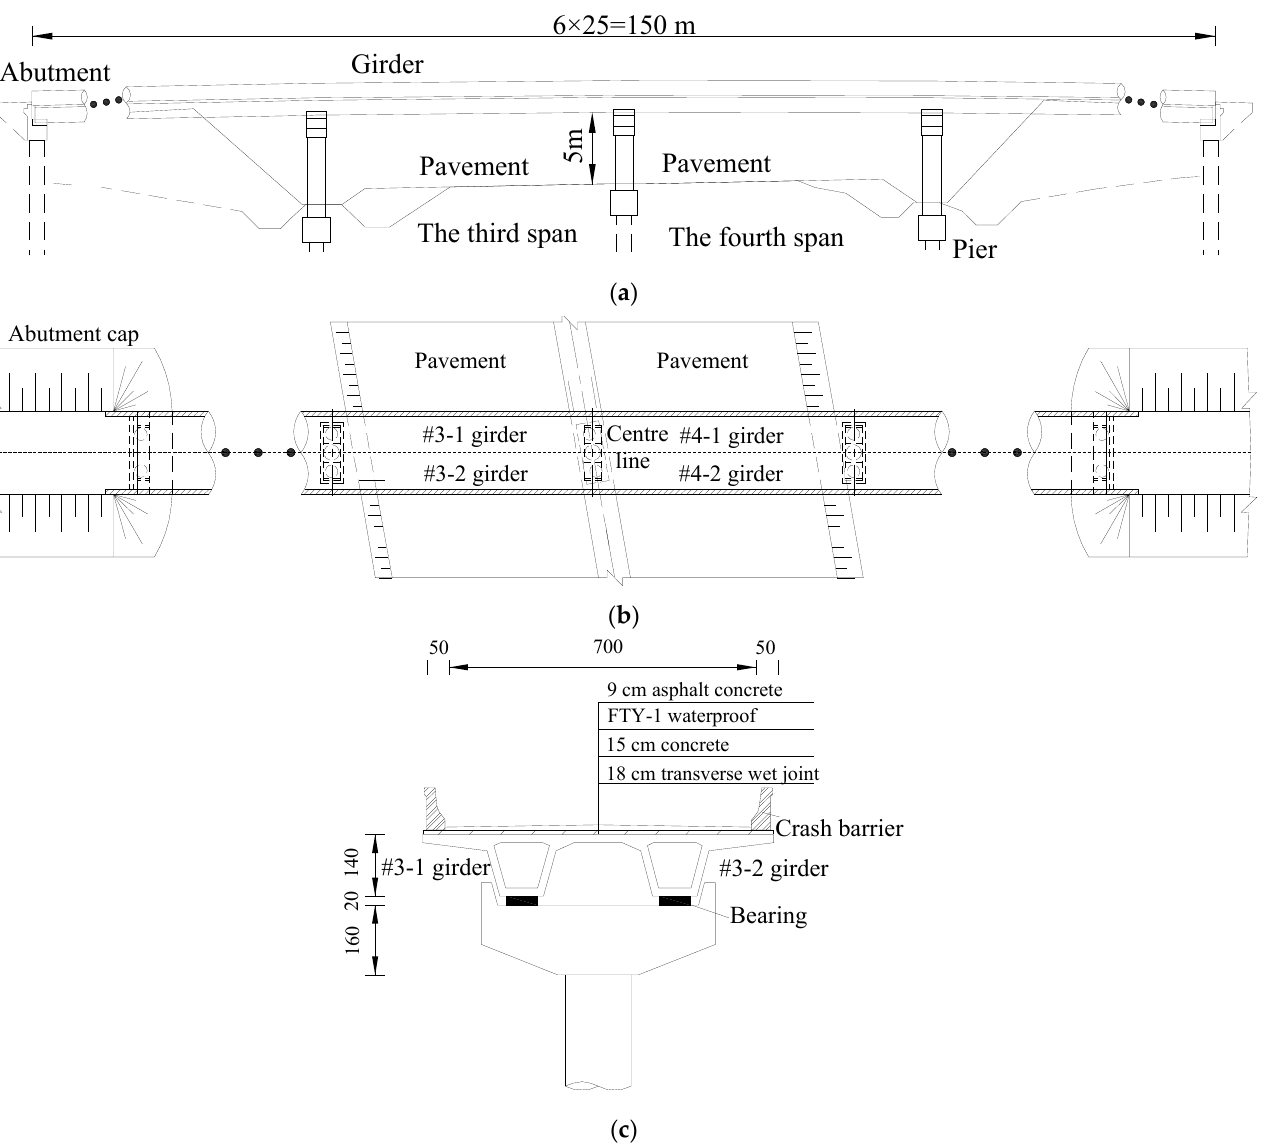
Figure 1. Details of the entire bridge arrangement. ( a ) Elevation arrangement (Unit: m); ( b ) Plane layout; ( c ) Cross-sectional layout (Unit: cm).